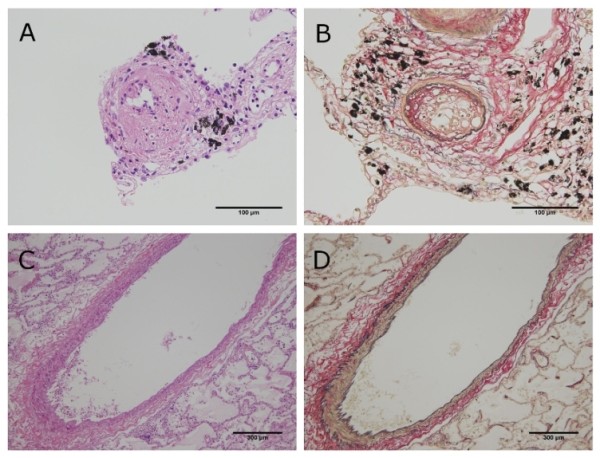
Histopathological findings of pulmonary tumor thrombotic microangiopathy in case 2. (A and B) Fibrocellular intimal proliferation occludes the lumen of the pulmonary artery under 100 μm in diameter (Hematoxylin-eosin (HE) double stain and elastica van Gieson (EVG) stain, × 400). (C and D) Neither prominent fibrocellular intimal proliferation nor carcinoma cells were present in the pulmonary artery over 300 μm in diameter (HE double stain and EVG stain, × 40).